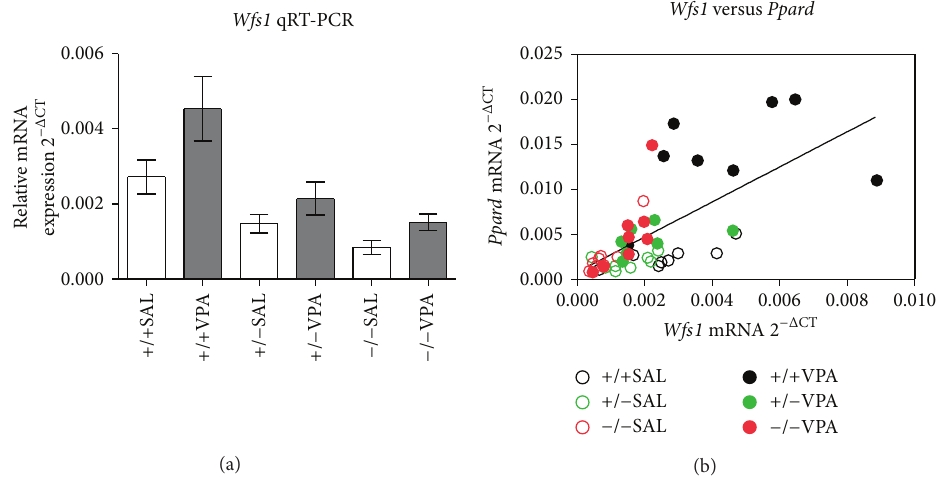
Figure 4: qRT-PCR analysis of Wfs1 expression in hepatic tissue of WT and Wfs1 mutant mice. qRT-PCR mRNA expression is represented as the mean of quadruplicate per sample against the endogenous reference gene Actb. (a) Chronic treatment with valproic acid (VPA) induces upregulation of Wfs1 expression ( 𝐹(1,41) = 7.72 ; 𝑃 = 0.0082 ). Expression level of Wfs1 follows a gene-dose relationship with Wfs1 genotype ( 𝐹(2,41) = 15.38 ; 𝑃 < 0.0001 ). All data are presented as means ± SEM ( 𝑛 = 8 ) and were compared by two-way analysis of variance (ANOVA). (b) Relationship between the expression levels of Wfs1 and Ppard , linear regression across all data points 𝑅 2 = 0.433 ( 𝑃 < 0.0001 ), and expression levels of Ppard and Wfs1 were measured using qRT-PCR, each point corresponds to one animal.